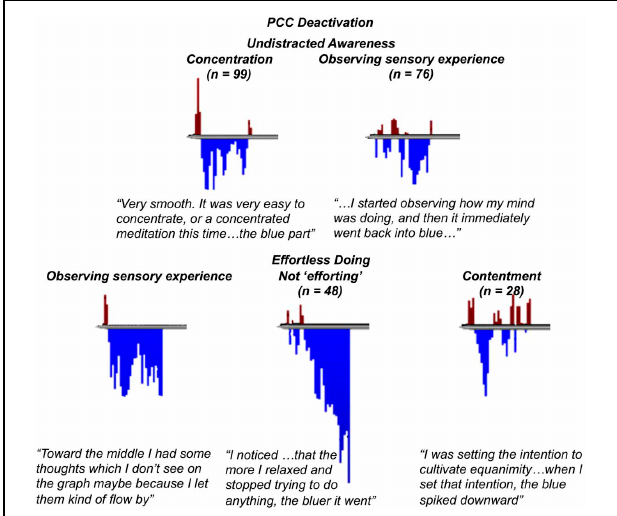
FIGURE 4 | “Undistracted awareness” and “effortless doing” as basic eliciting factors of posterior cingulate cortex deactivation. Examples of self-report transcripts and feedback graphs for the theoretical codes leading to the basic eliciting factors of “undistracted awareness” (top) and “effortless doing” (bottom) .